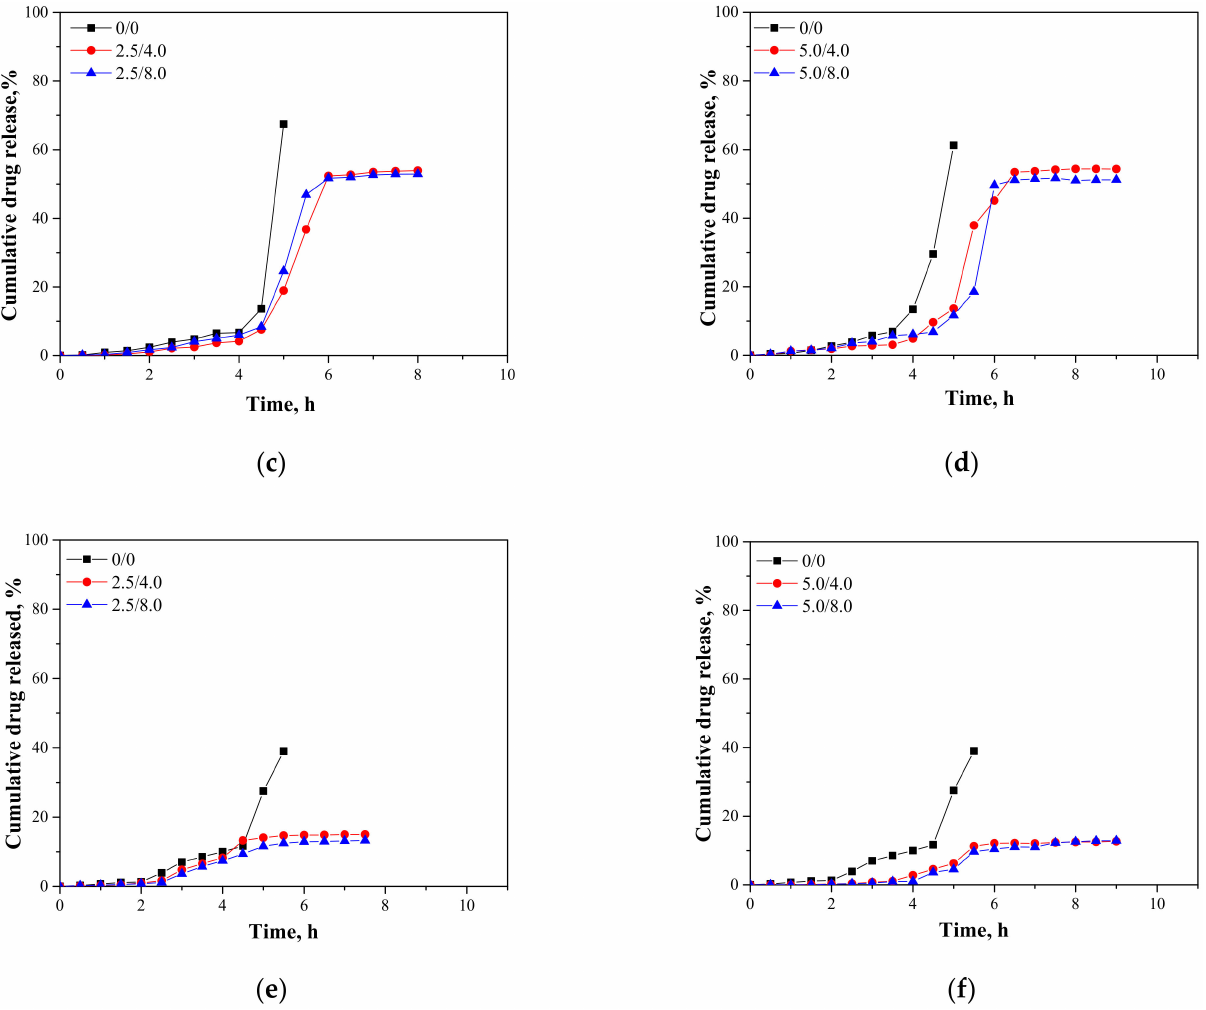
Figure 15. Release profiles of active substance from hydrogels in environment at pH = 2.0—samples containing 2.5 mL ( a ) and 5.0 mL ( b ) of albumin spheres; pH = 5.5—samples containing 2.5 mL ( c ) and 5.0 mL ( d ) of albumin spheres; and pH = 7.4—samples containing 2.5 mL ( e ) and 5.0 mL ( f ) of albumin